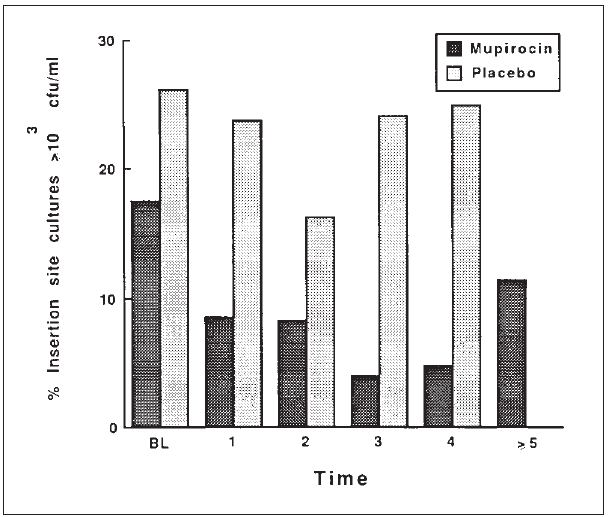
Figure 2) Percentage of insertion site cultures 10 3 colony forming units (cfu)/mL/25 cm 2 or greater (intervals of 48 h) for all staphylococ-